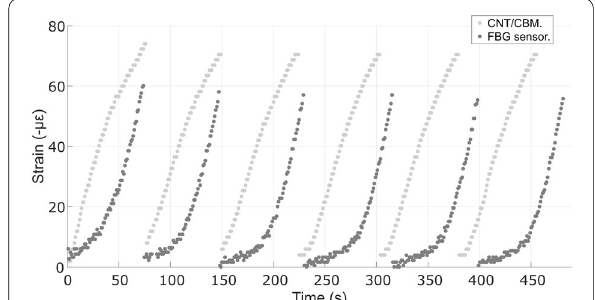
Fig. 11 Behavior of the piezoresistive response of the CBM/CNT against the state of damage and no damage for the RC beam. Dynamic load from 0 to 15 kN.